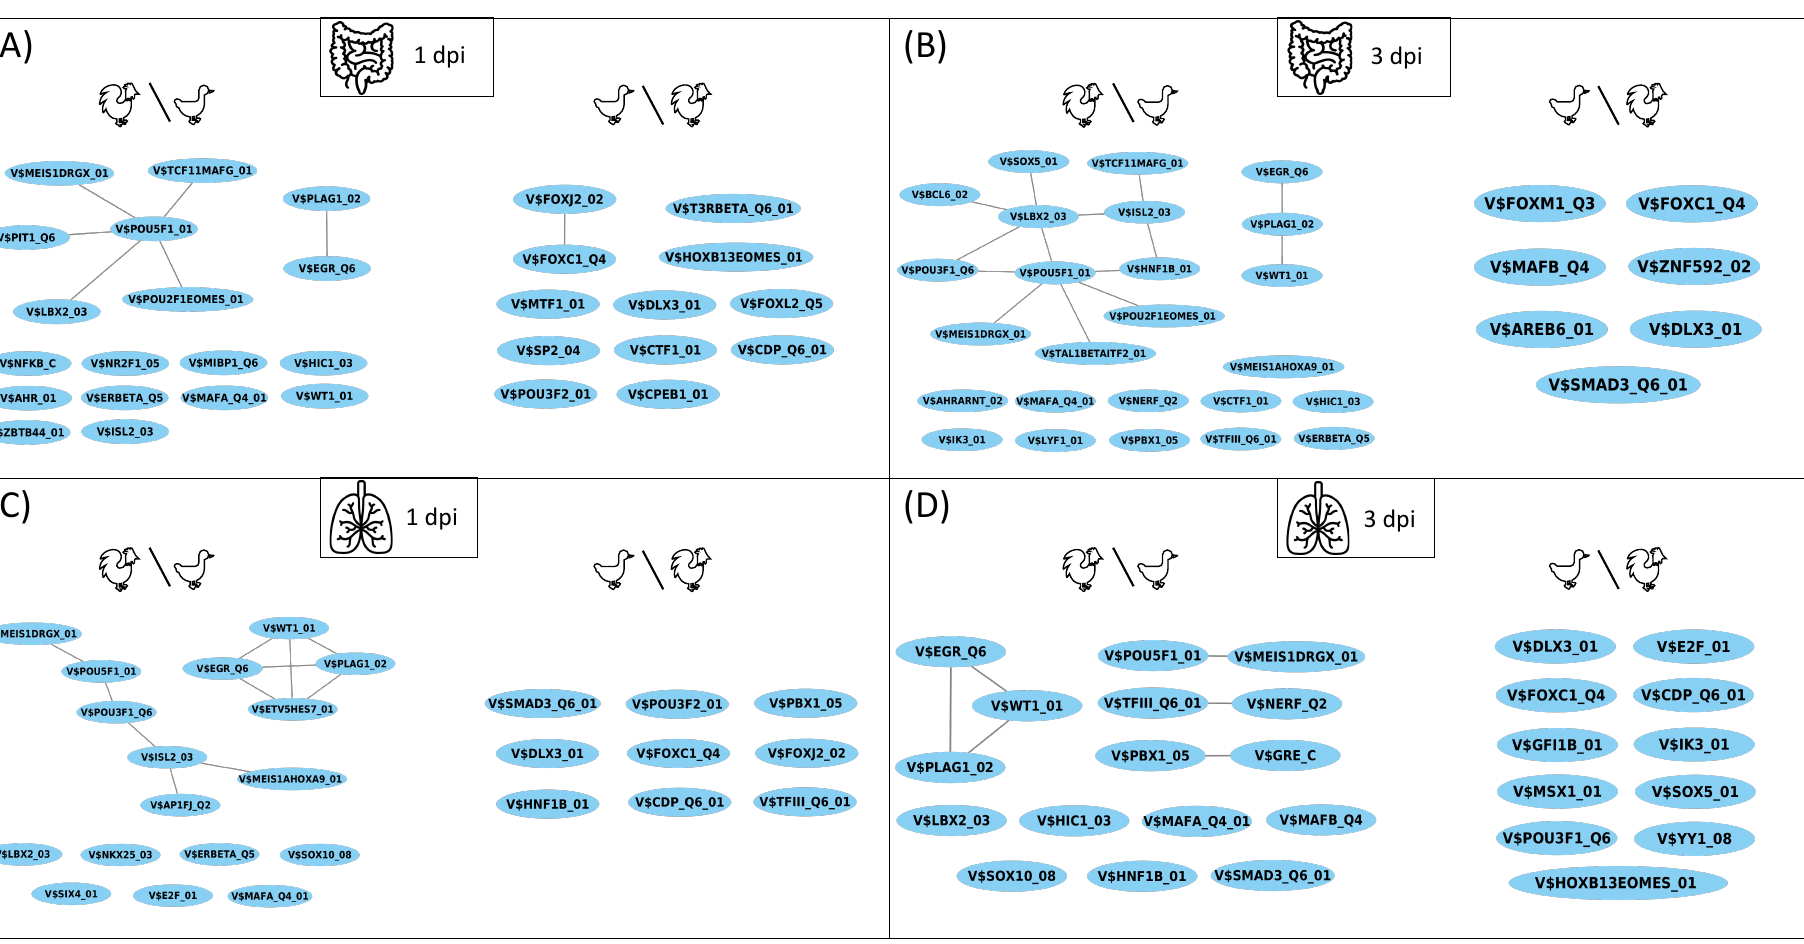
Figure 4. Differences in transcription factor (TF) cooperation networks found by the PC-TraFF algorithm for ( A ) ileum 1 dpi, ( B ) ileum 3 dpi, ( C ) lung 1 dpi and ( D ) lung 3 dpi with HPAIV H5N1. The difference in nodes in the networks of duck and chicken is denoted by the set difference sign ( \ ). The nodes are labeled by the PWM names representing TFs, as given by TRANSFAC [44]. They follow the structure V$ factorname_version , where “V$” indicates that the PWM originates from a vertebrate TF, factorname specifies the name of the corresponding TF, and version is specified to uniquely identify the PWM. The networks were visualized with Cytoscape [74]. Full size image is provided in Figure